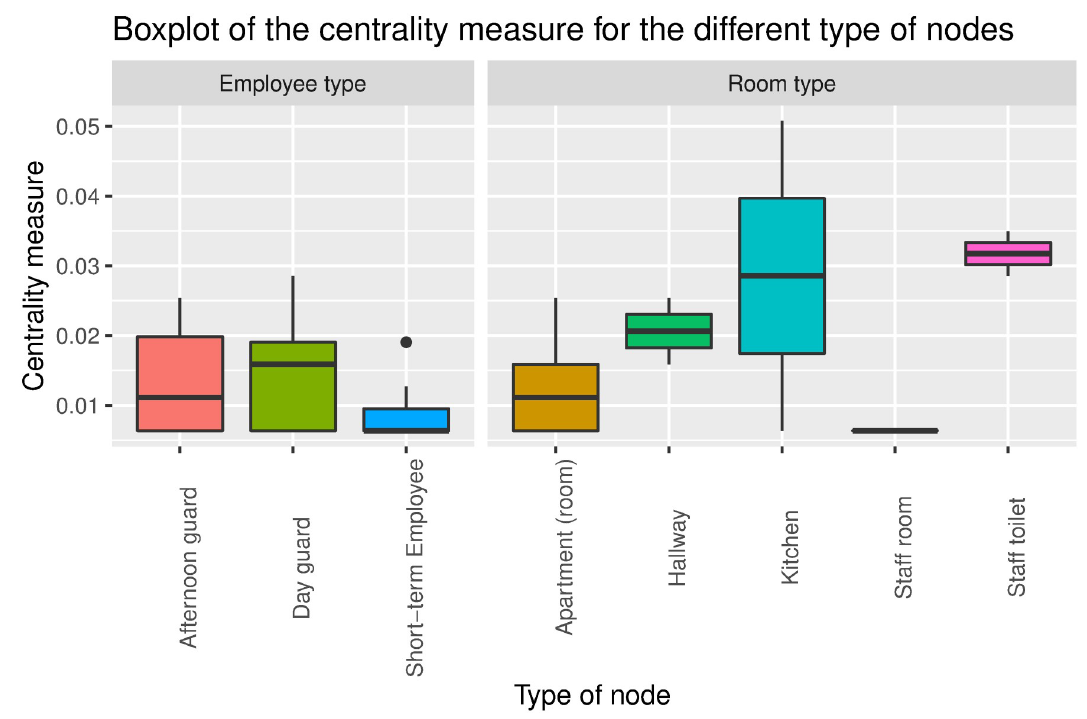
Fig 6. Boxplot showing rooms where the duration of the encounters are above 15 minutes at S ø lund nursing home.